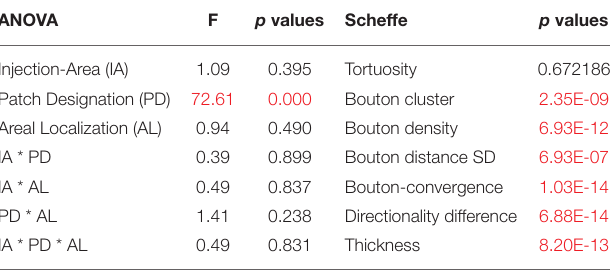
Significant p-value is highlighted by red. Injection-Area: area 3b vs. area 1; patch designation:Pvs.NPaxons;areallocalization:intra-arealvs.inter-arealaxons.Interactions are indicated by the “ * ” symbol. Other conventions are the same as in prior tables.